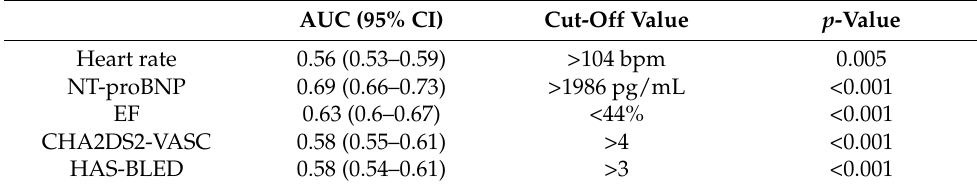
Table 3. Determinants of prolonged LOS-ROC curve analysis.